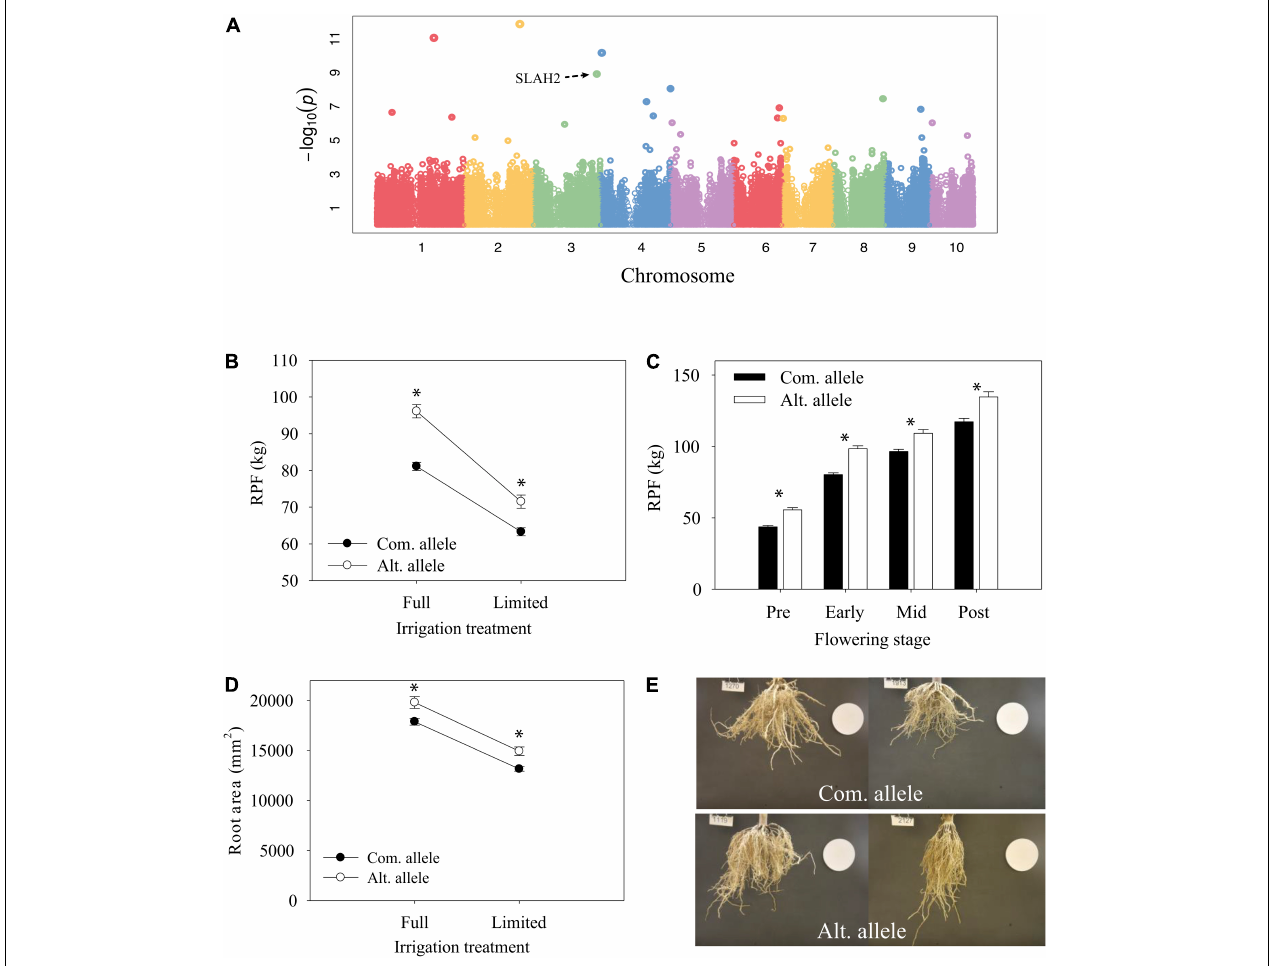
FIGURE 9 | Allele differences at candidate gene SLAH2 . (A) Genome-wide association mapping of RPF under well-irrigated conditions at 2018 early-flowering stage. (B) Reaction norm of RPF from 2018 early-flowering measurements for lines with contrasting alleles (ls mean ± SE). (C) Differences in RPF by allele across developmental time points for the full-irrigation treatment (mean ± SE). ∗ Indicates a significant difference, P < 0.05. (D) Reaction norm of root area (mean ± SE). (E) Representative root images for lines with the common allele (top) or alternate allele (bottom).